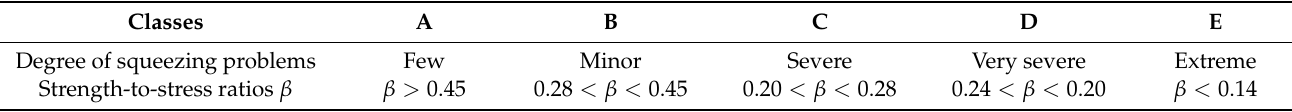
Table 3. Classes of difficulty associated with tunneling through squeezing rock based on Hoek [38]. Classes Degree of squeezing problems Few Minor Severe Very severe Extreme Strength-to-stress ratios β β > 0.45